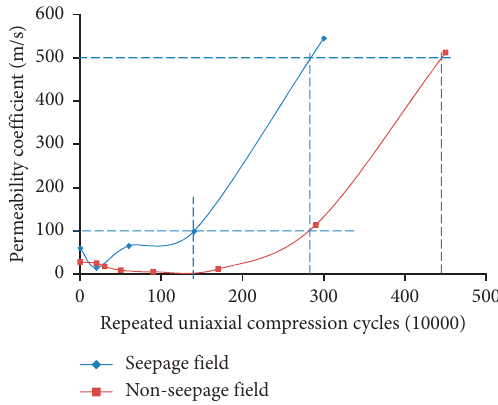
Figure 15: Relationship between repeated uniaxial compression cycles and permeability